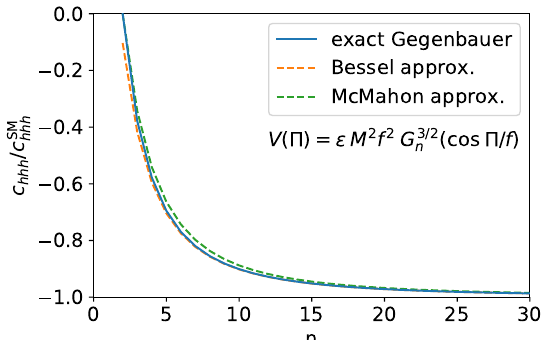
Figure 2 . Higgs trilinear self-coupling as a function of n , for a pure Gegenbauer potential V (Π) = (cid:15) M 2 f 2 G ( N − 1) / 2 n (cos Π /f ) with N = 4 . In the large- n limit, the location of the global minimum is approximated using the first Bessel zero h Π i /f ≈ j / ( n + λ ) . The latter can λ +1 / 2 , 1 further approximated by the first term of the McMahon formula j ≈ π (1 + λ/ 2) . λ +1 / 2 , 1 where j denotes the first zero of the Bessel function of order λ + 1 / 2 . Its numerical λ +1 / 2 , 1 value for λ = ( N − 1) / 2 with N = 4 is j ≈ 5 . 1356 . Importantly, this global minimum is 2 , 1 at a small non-zero value, scaling inversely with n . Thus Gegenbauer potentials provide a than the scale of spontaneous symmetry breaking in pNGB Higgs